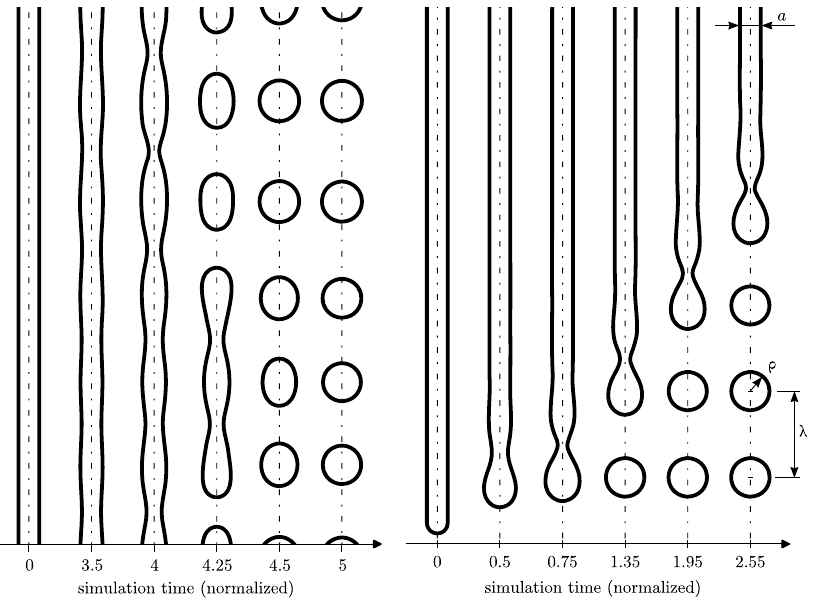
Figure 1. (left) Rayleigh instability in an infinite cylindrical pore. (right) Instability in a finite